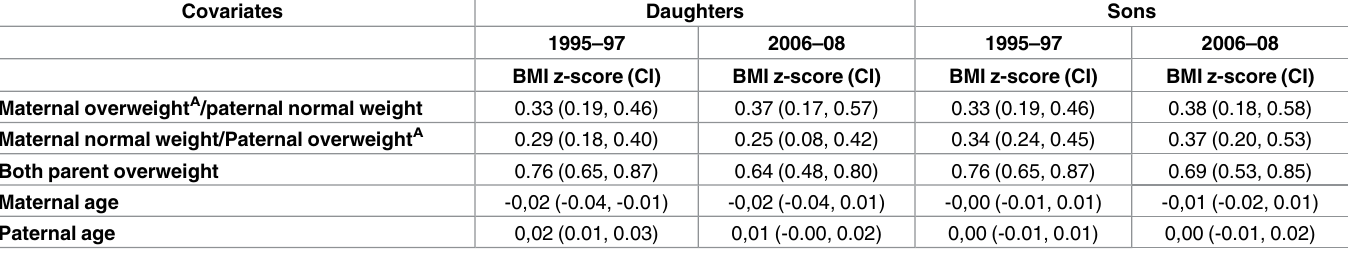
Table 2. Age adjusted association between parental body mass index (BMI) based overweight and offspring BMI z-score (standard deviations from their means) in 1995–97and 2006–08.